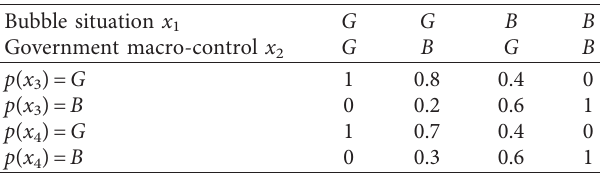
Table 3: Probability table of expert forecast conditions for in- dustrial development and the aviation industry development in September 2019.